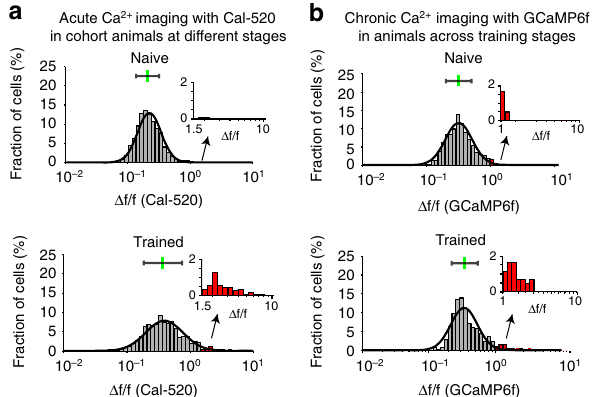
Fig. 4 Comparing Ca 2 + imaging datasets using Cal-520 with those using GCaMP6f. Histograms of trial-averaged Ca 2 + response amplitudes for pooled populations of cells ( a upper: n = 1314 cells pooled from eight naive animals, lower: n = 1112 cells pooled from 18 animals imaged with Cal-520; b upper and lower: the same n = 423 cells pooled from 10 animals imaged with GCaMP6f). Each histogram is fi tted by a lognormal function, and the inset panel shows an enlarged view of the histogram tail for Δ f / f ≥ 1.5 (Cal- 520) and Δ f / f ≥ 1.0 (to ≤ 20%, one-way ANOVA, P = 5e − 5; n = 8 subsessions) in an